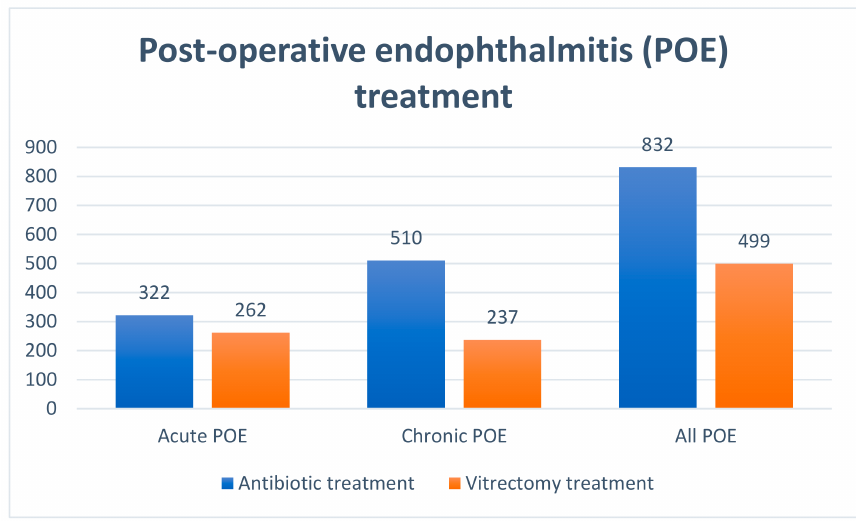
Figure 1. Treatment of postoperative endophthalmitis (POE) after cataract surgery in Poland